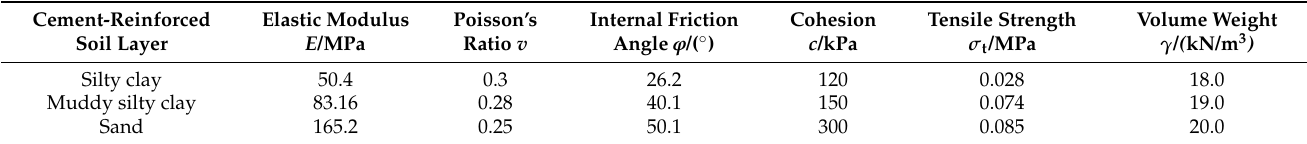
Table 2. Physical and mechanical parameters of the